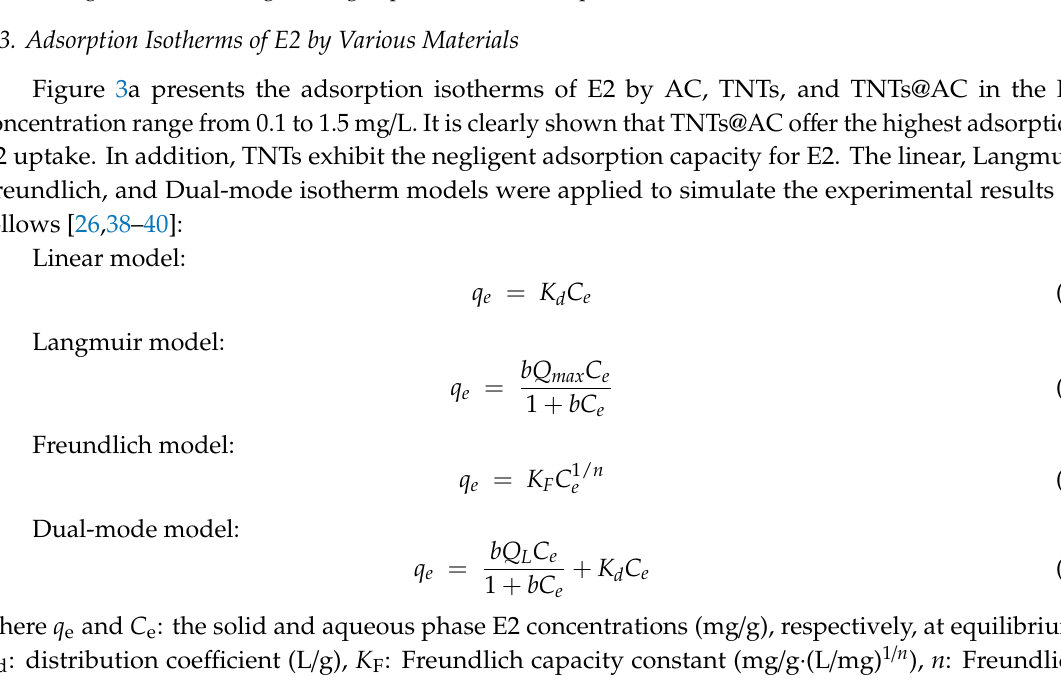
Figure 2. Adsorption kinetics of 17 β -estradiol (E2) by TNTs@AC. (Initial E2 concentration = 0.5 or 1.0 mg / L, material dosage = 0.5 g / L, pH = 7.0 ± 0.2, temperature = 25 ± 0.2 ◦ C).